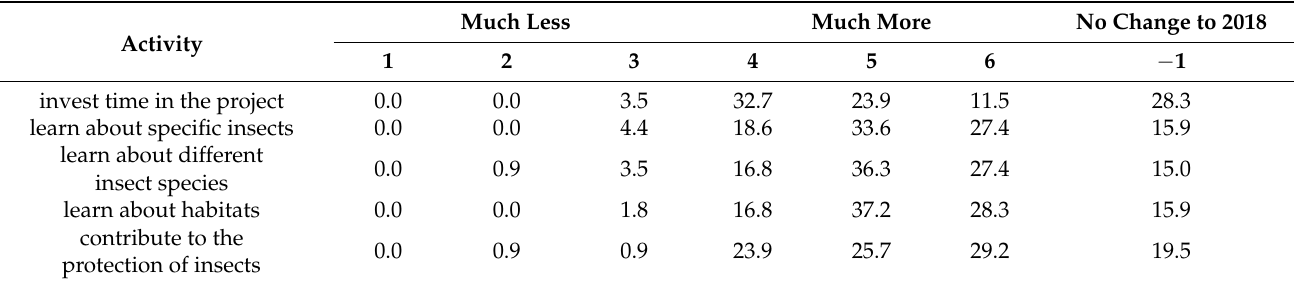
Table 4. Intended participation in 2019 1